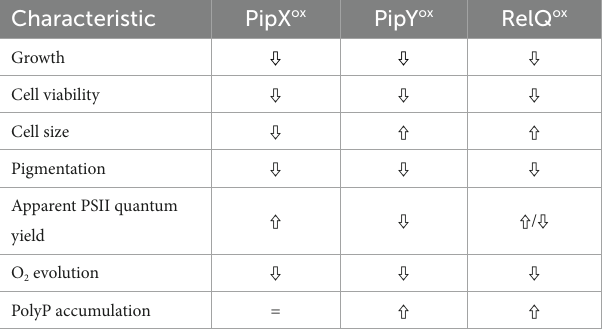
TABLE 2 Impact of PipX, PipY and RelQ protein overexpression in S. elongatus features. Characteristic